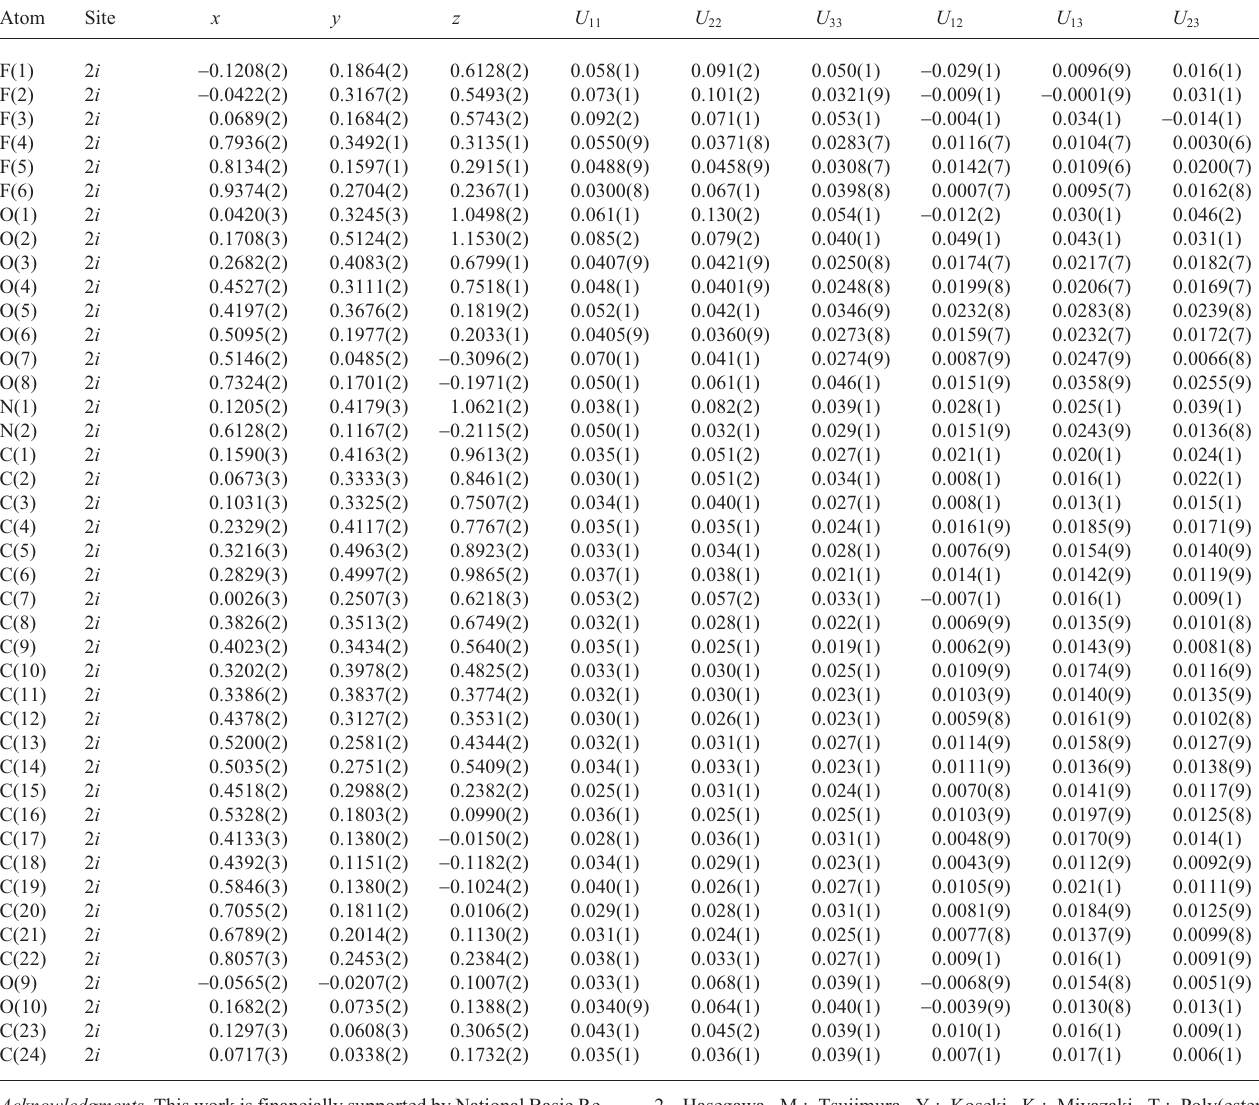
Table 3. Atomic coordinates and displacement parameters (in Å 2 )